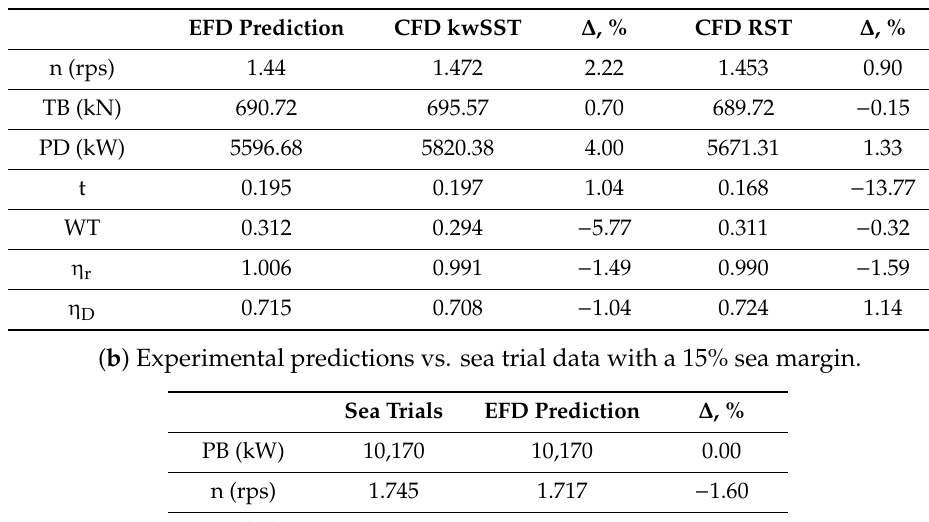
Table 1. Comparison of propulsion characteristics between the numerical and experimental predictions and full-scale trial data for the vessel without